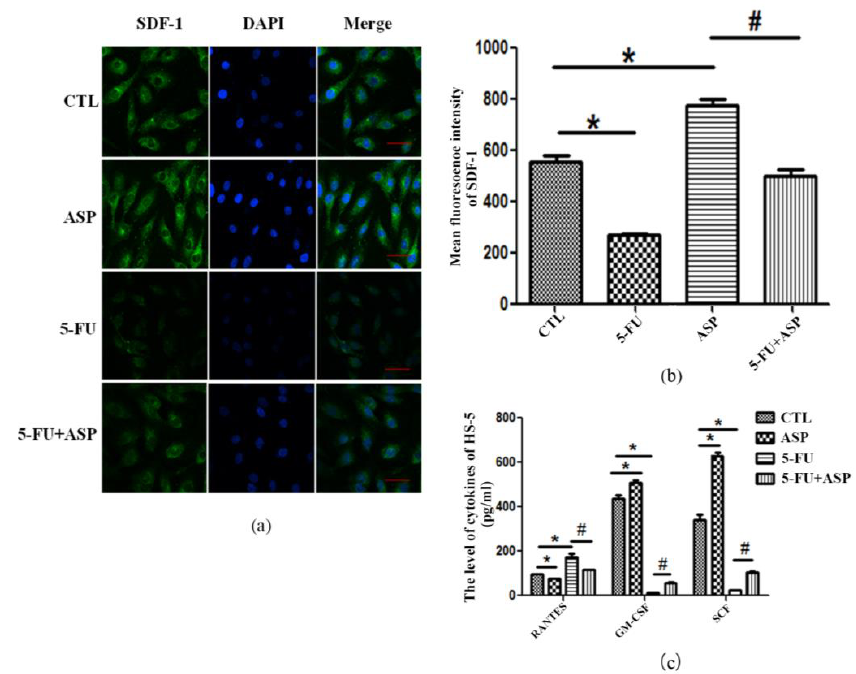
Figure 5. ASP recovers cytokines production from 5-FU injured bone marrow stromal cells: ( a ) SDF-1 (also named CXCL12) protein expression in HS-5 cells is detected via confocal laser scanning microscopy and shown from a merged image of FITC-conjugated SDF-1 and DAPI staining of the nuclei in control ( top ), ASP-treated ( the second panel ), 5-FU-treated ( the third panel ) and 5-FU + ASP-treated ( bottom ) cells (Scale bar = 50 μm); ( b ) Mean fluorescence intensity of SDF-1 was quantified and is presented as means ± SD; ( c ) (ELISA) assay was employed to detect the levels of cytokines produced by HS-5 cells. The results are presented as means ± SD. * p < 0.01 vs. control group, # p < 0.01 vs. 5-FU group.